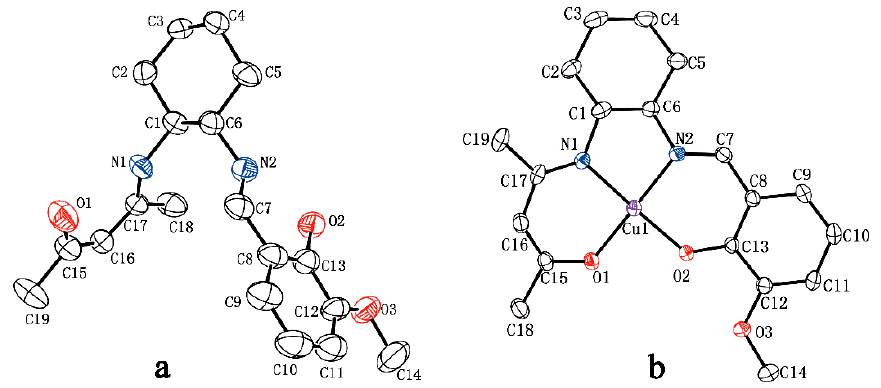
Figure 4. ( a ) X-ray crystal structure of probe L ; ( b ) X-ray crystal structure of Cu-complex. Thermal ellipsoids are set at the 30% probability level and all hydrogen atoms and solvent molecules were omitted for clarity.